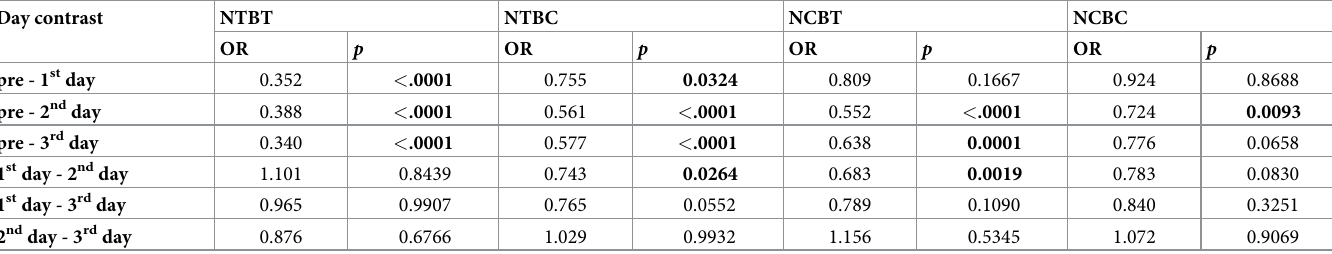
Table 4. Summaries of the post-hoc tests for pairwise comparisons of Days on each group.